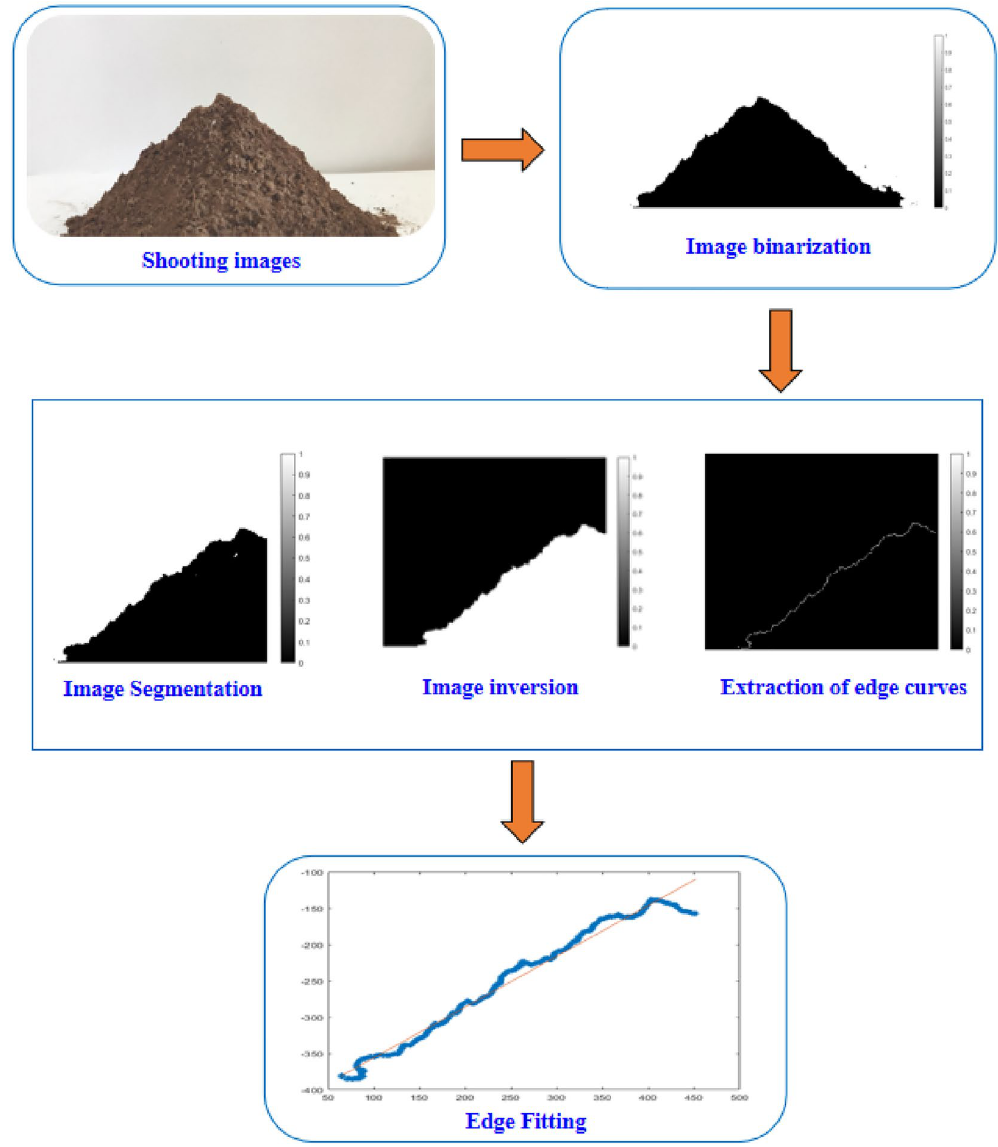
Figure 5. Image processing process for automatic measurement of stacking